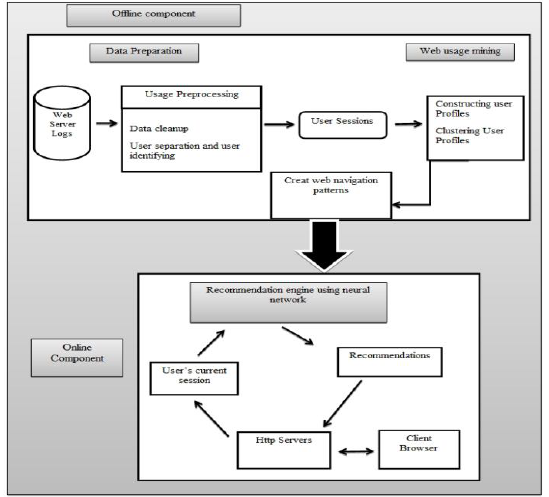
Fig. 1. The architecture of the proposed